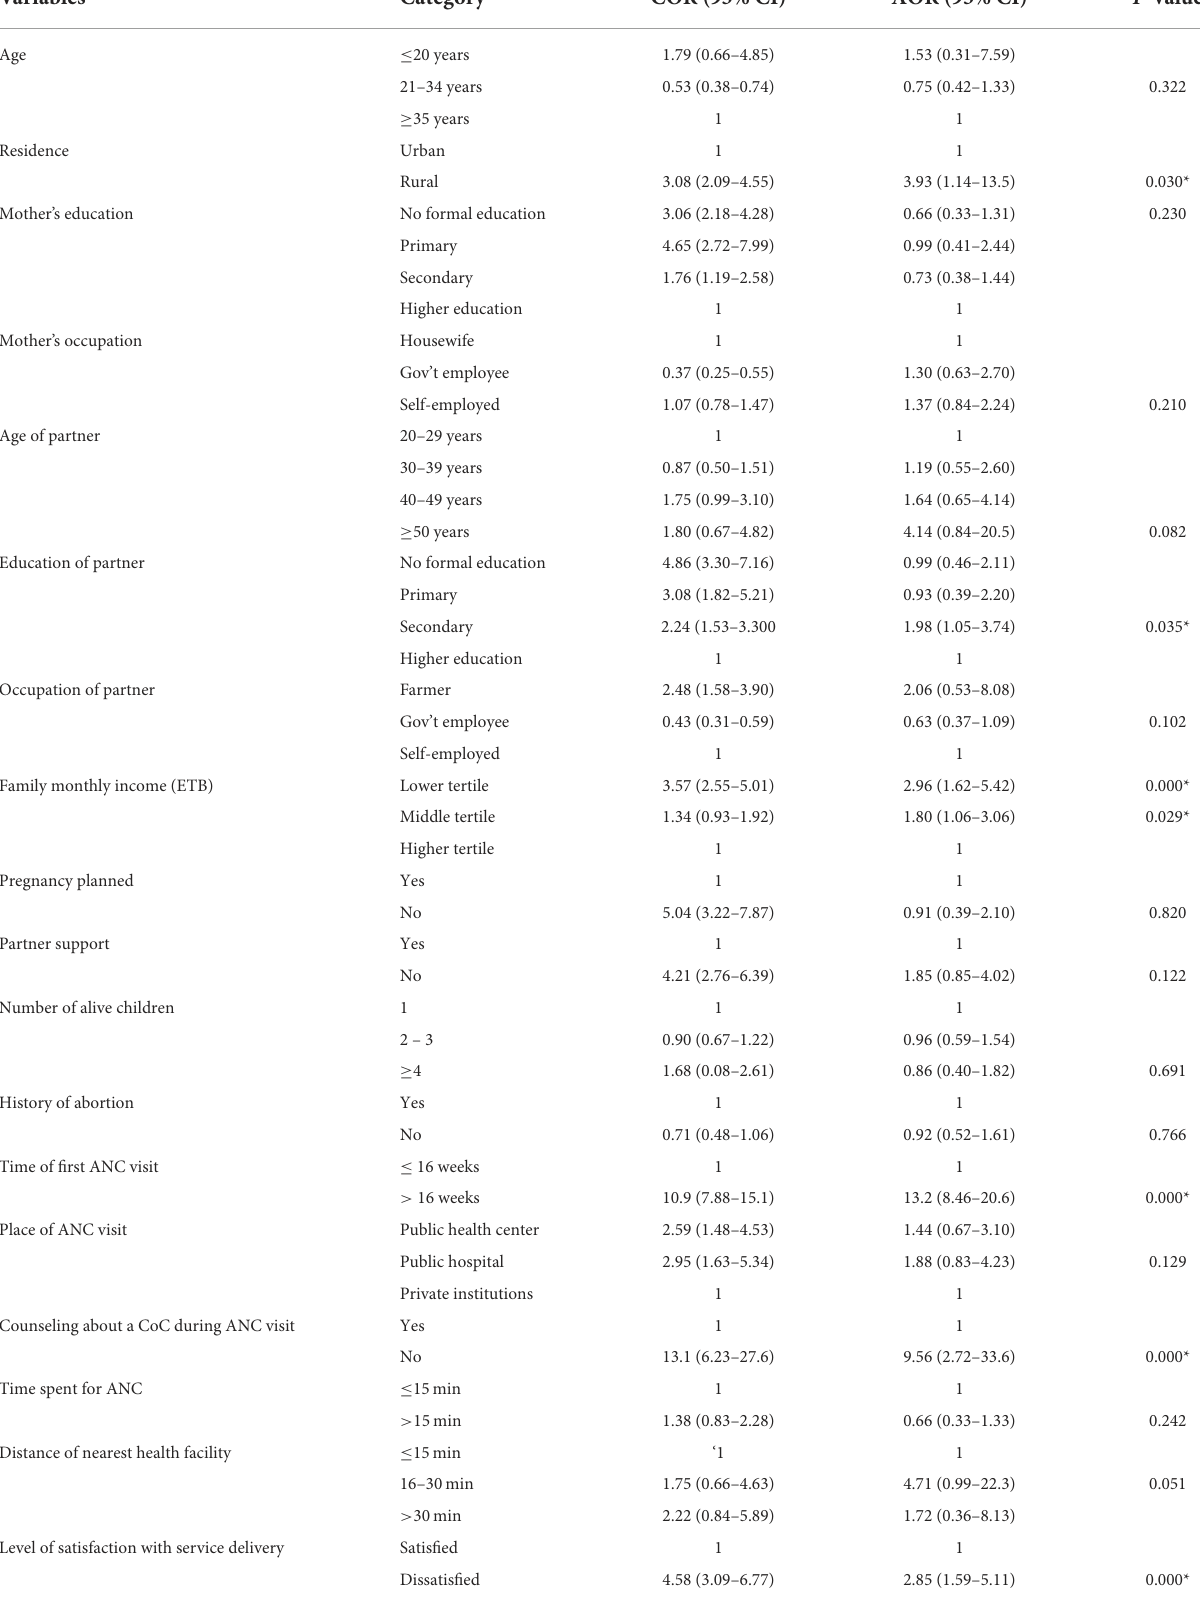
TABLE 4 Bivariable and multivariable logistic regression analyses of variables with antenatal care dropout in northeast Ethiopia.